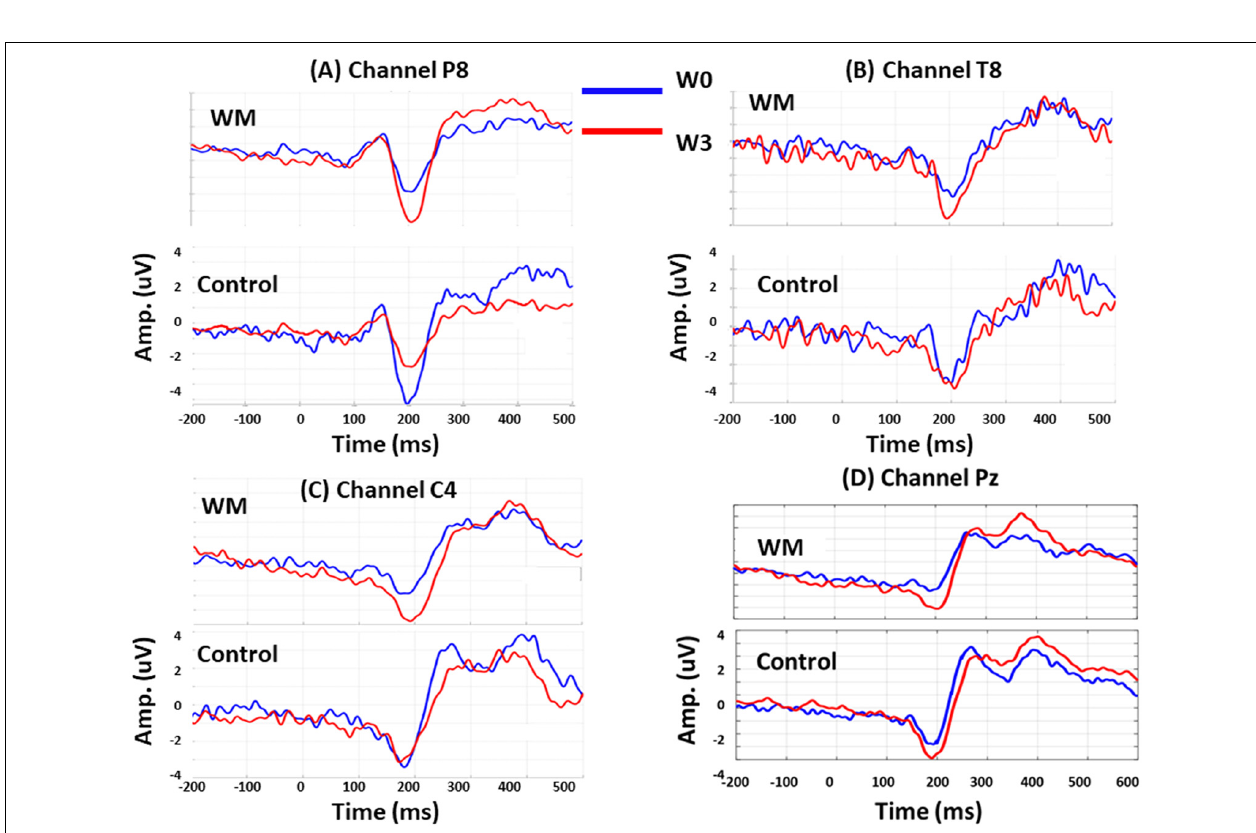
significant increase in N160 amplitude at P8 ( p = 0.046), T8 ( p = 0.006), and C4 ( p = 0.038) at W3 after training. Specifically, the N160 peaks over P8 revealed different patterns for training and practice. At W3, the N160 amplitude of the WM group increased ( p = 0.008) but that of the control group decreased ( p = 0.017) when compared with those at W0.